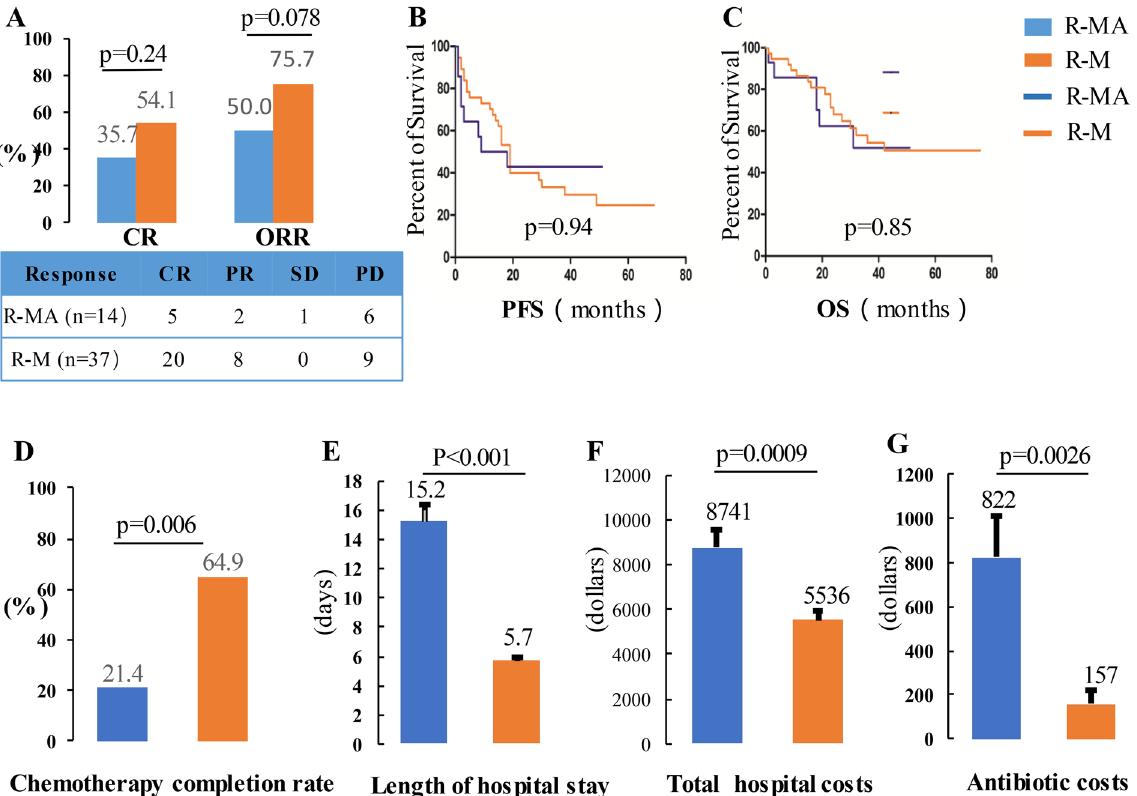
Figure 1. Response, survival and cost by treatment group. ( A ) Response; ( B ) Progression-free survival; ( C ) Overall survival; ( D ) Chemotherapy completion rate; ( E ) Average length of hospital stay; ( F ) Average total hospital cost per course per patient; ( G ) Average antibiotic costs per course per patient.